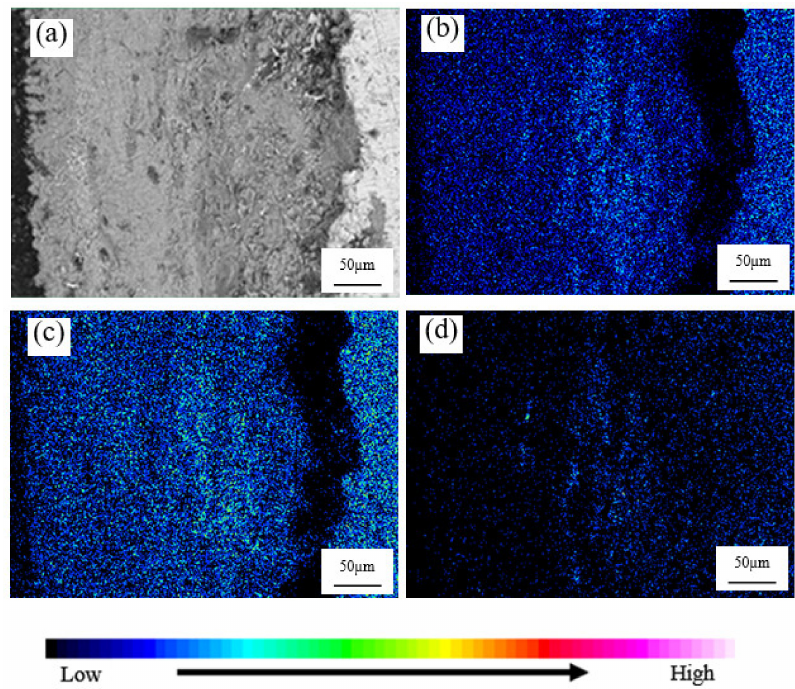
Figure 6. Chemical analysis of rust section of 60Si2Mn-B sample in the period of 360 h: ( a ) cross- section of rust layer; ( b ) Cu, ( c ) Ni, and ( d )